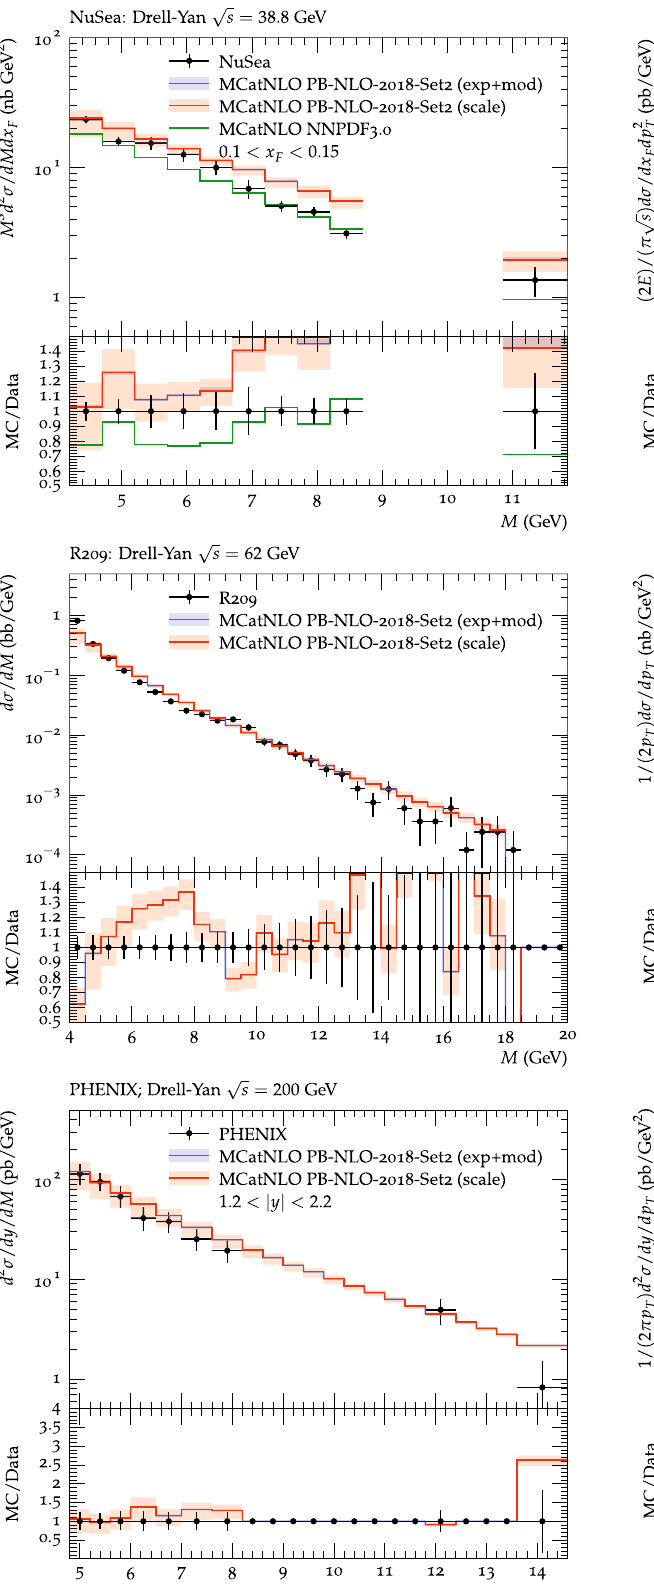
Fig. 5 Drell–Yan mass distribution production measured by NuSea [42,43], R209 [41] and PHENIX [40] compared to pre- dictions at NLO using PB-TMDs. For NuSea also the prediction using NNPDF3.0 [50] is shown